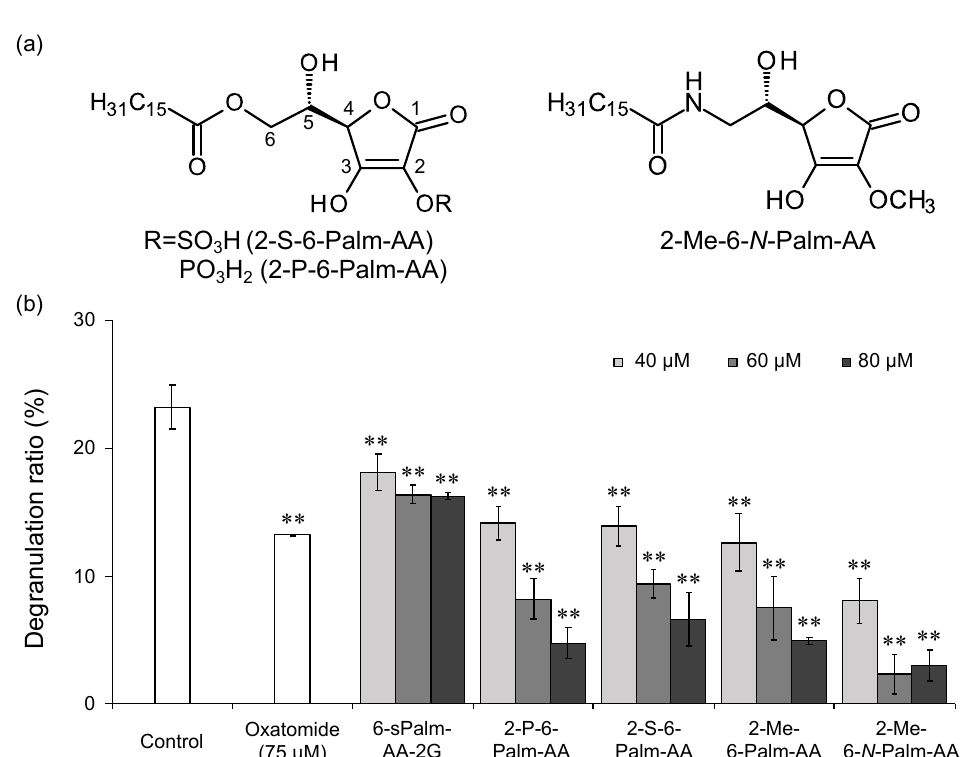
Figure 4. Structures of 6-Palm-AA derivatives with different substituents at the C-2 or C-3 position ( a ) and the inhibitory effects of the 6-Palm-AA derivatives on antigen-induced degranulation ( b ). All data represent the means ± SD of three independent experiments. ** p < 0.01 (Dunnett’s test) as compared with the control.